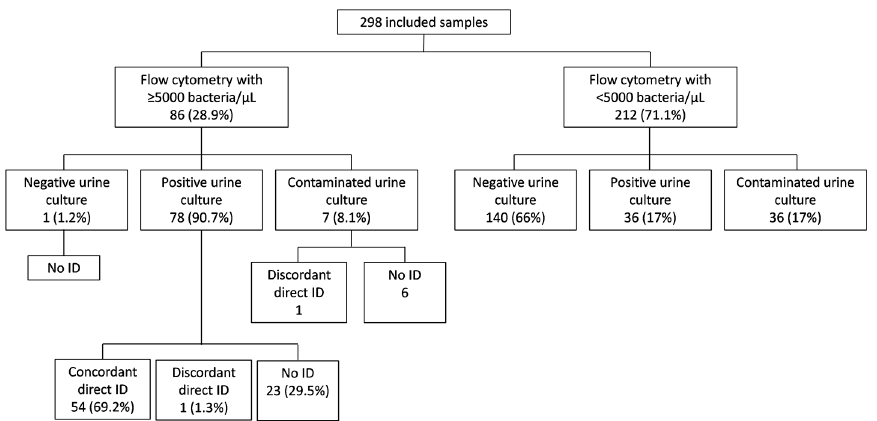
Figure 1. Results of the 298 samples analyzed. ID,